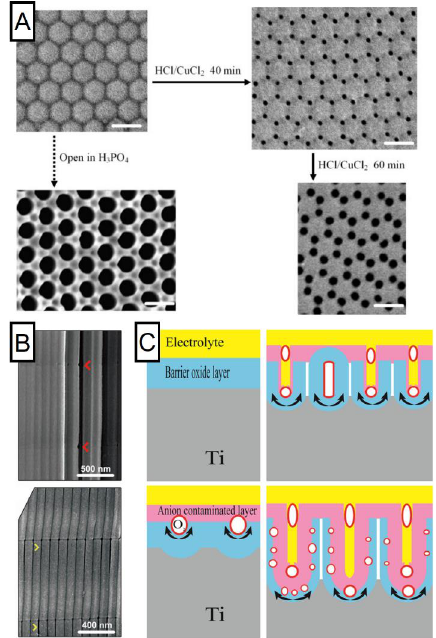
Figure 7. Structure periodical discrepancies and schematic explanation of its formation. ( A ) Selective etching with HCl/CuCl 2 and H 3 PO4 of structure with local differences in material morphology. Re- printed (adapted) with permission from [118]. Copyright 2007 Wiley. ( B ) SEM images of the struc- ture before (upper panel) and after (bottom) acid etching with visible void formation. Reprinted (adapted) with permission from [122]. Copyright 2015 Elsevier. ( C ) Schematic representation of the cavities formation between double walls of growing titania nanotubes. Reprinted (adapted) with permission from [126]. Copyright 2019 Elsevier.